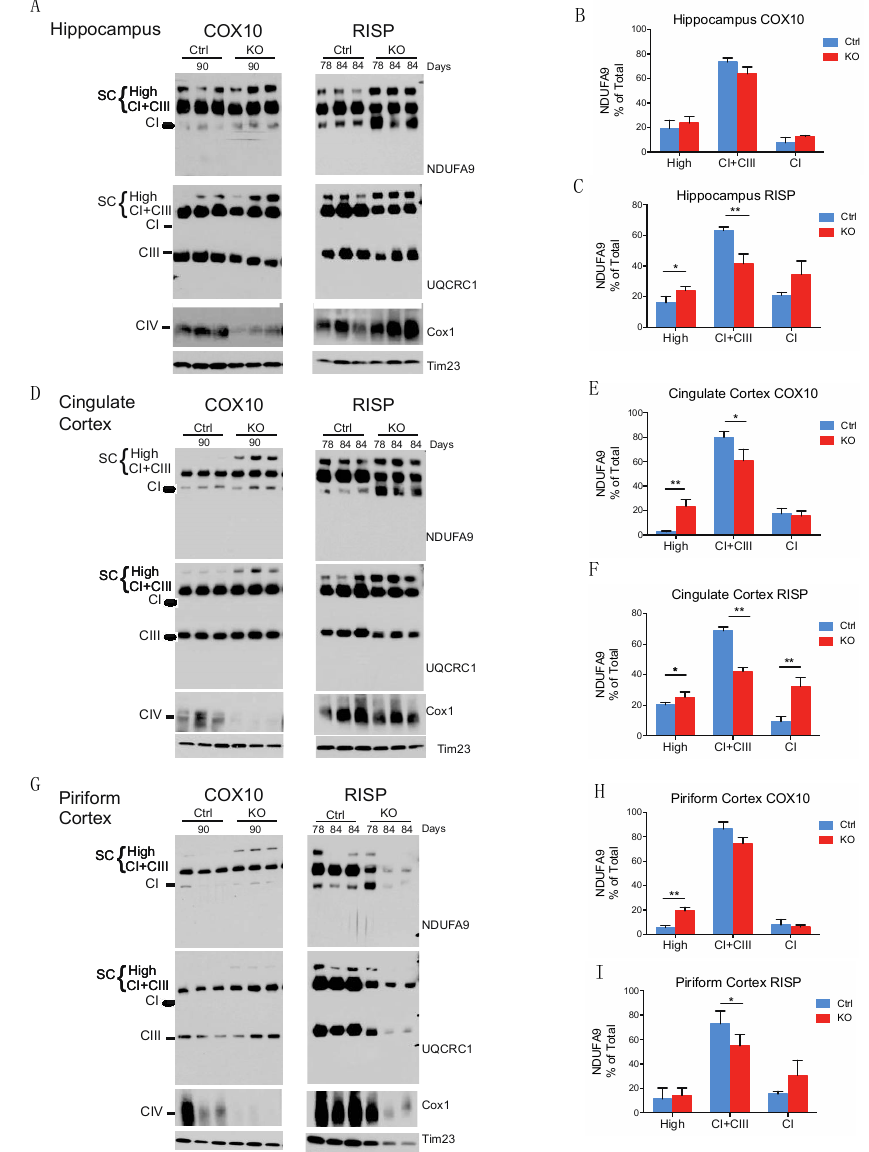
Figure 1. Blue native gel electrophoresis analysis of mitochondrial supercomplexes in brain regions of neuron-specific COX10 and RISP KO mice. Mitochondrial fraction was isolated from the different brain regions of control and KO mice at different ages (78–90 days). Mitochondrial proteins were extracted with digitonin and separated by blue native gel electrophoresis followed by western blot. CI, CIII and CIV were analyzed using NDUFA9, UQCRC1 and Cox1 antibodies respectively. Tim23 was used as mitochondrial loading control. Mitochondrial supercomplexes are indicated in the figure as SC (HMW and CI+CIII arrangements) in addition to free CI, free CIII and the monomer of CIV. Mitochondrial proteins were extracted from ( A ) hippocampus, ( D ) cingulate cortex and ( G ) piriform cortex from control and KO mice at ages indicated. ( B , C , E , F , H , I ) Graphs represent mean and standard deviation of levels of NDUFA9 normalized to Tim23 and expressed as percentage of total signal for hippocampus of COX10 ( B ) and RISP ( C ); cingulate cortex of COX10 ( E ) and RISP ( F ) and piriform cortex of COX10 ( H ) and RISP ( I ) mice. Antibody signals were quantified by densitometry of blots using ImageJ. (*) p < 0.05 and (**) p < 0.01 represents statistical significance, n = 3.